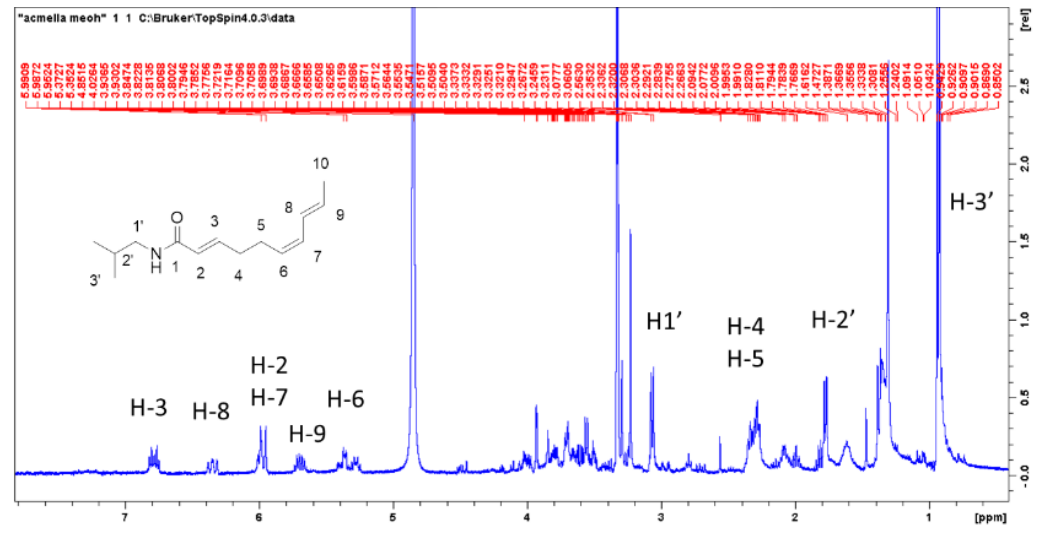
Figure 2. 1 H NMR of methanolic extract of Acmella oleracea (commercial sample) .